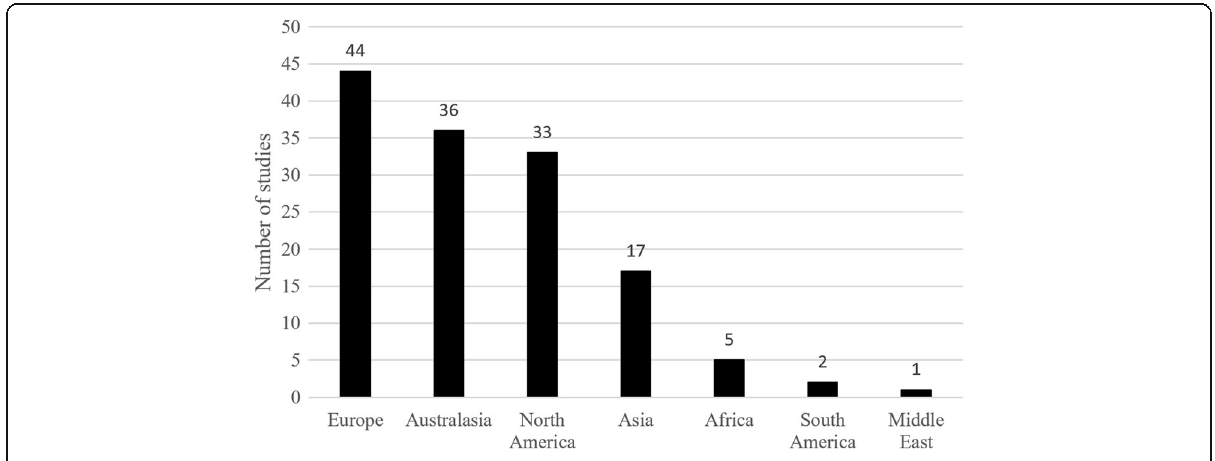
Fig. 2 Distribution of the studies by world regions (three of the studies were made in multiple